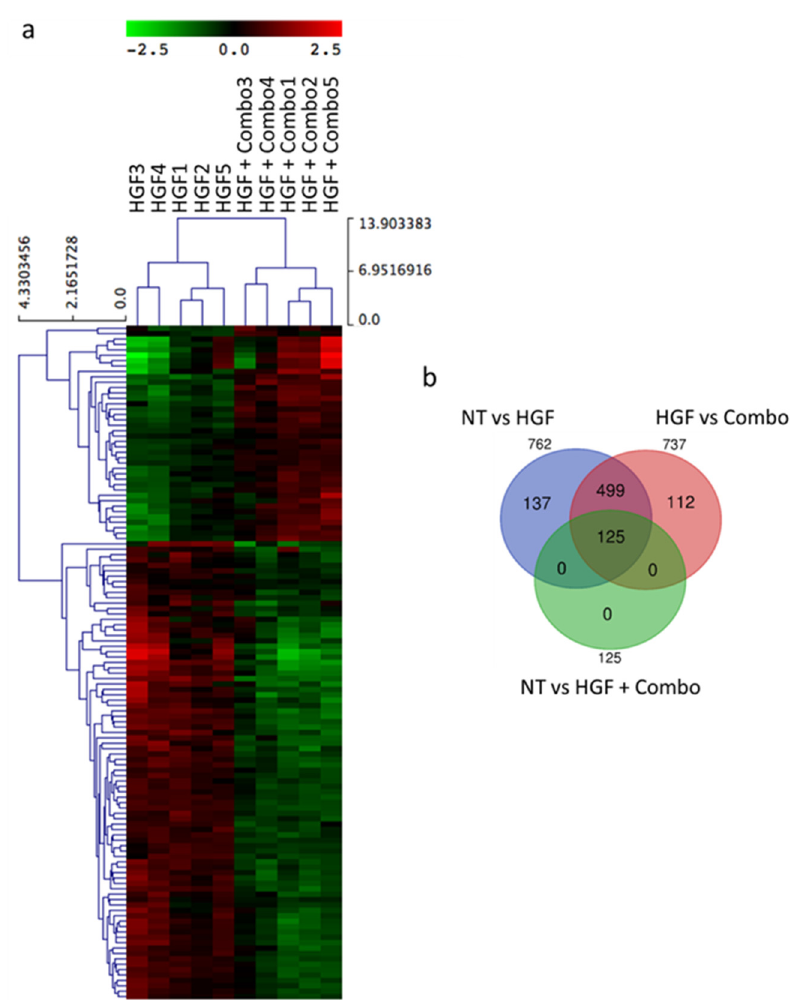
Figure 2. Gene expression analysis of HPAF-II cells in response to HGF/MET pathway modulation identifies 125 differentially expressed genes. ( a ) Hierarchical clustering of the 125 differential expressed genes obtained by comparing the expression profiles of HGF-stimulated HPAF-II cells (HGF 1–5) with those of HGF-stimulated HPAF-II cells treated with MvDN30 and DecoyMET K842E in combination (HGF + Combo 1–5). ( b ) Venn diagram displaying overlap among sets of differentially expressed genes.